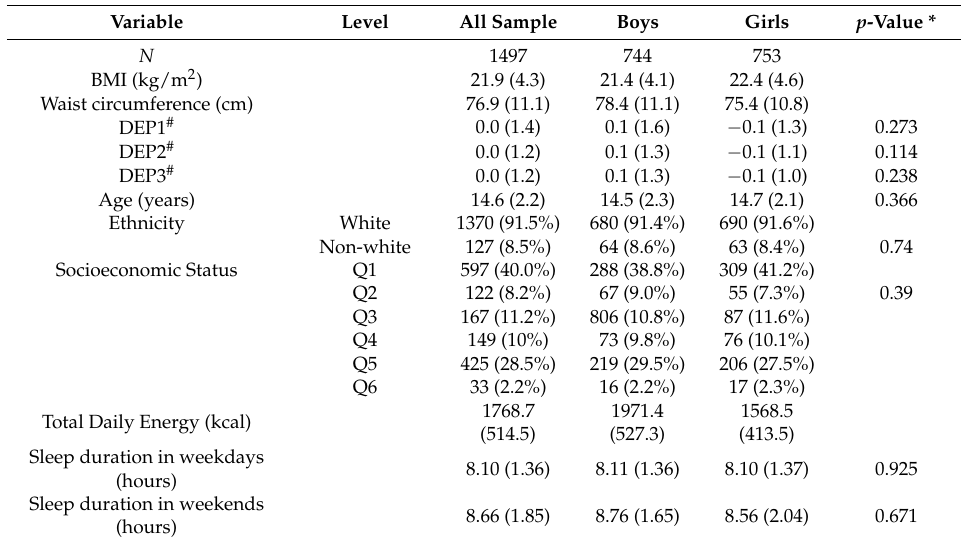
Table 1. The baseline descriptive characteristics (mean (SD) or count/percentage) before multiple imputation for the unweighted survey whole sample and stratified by